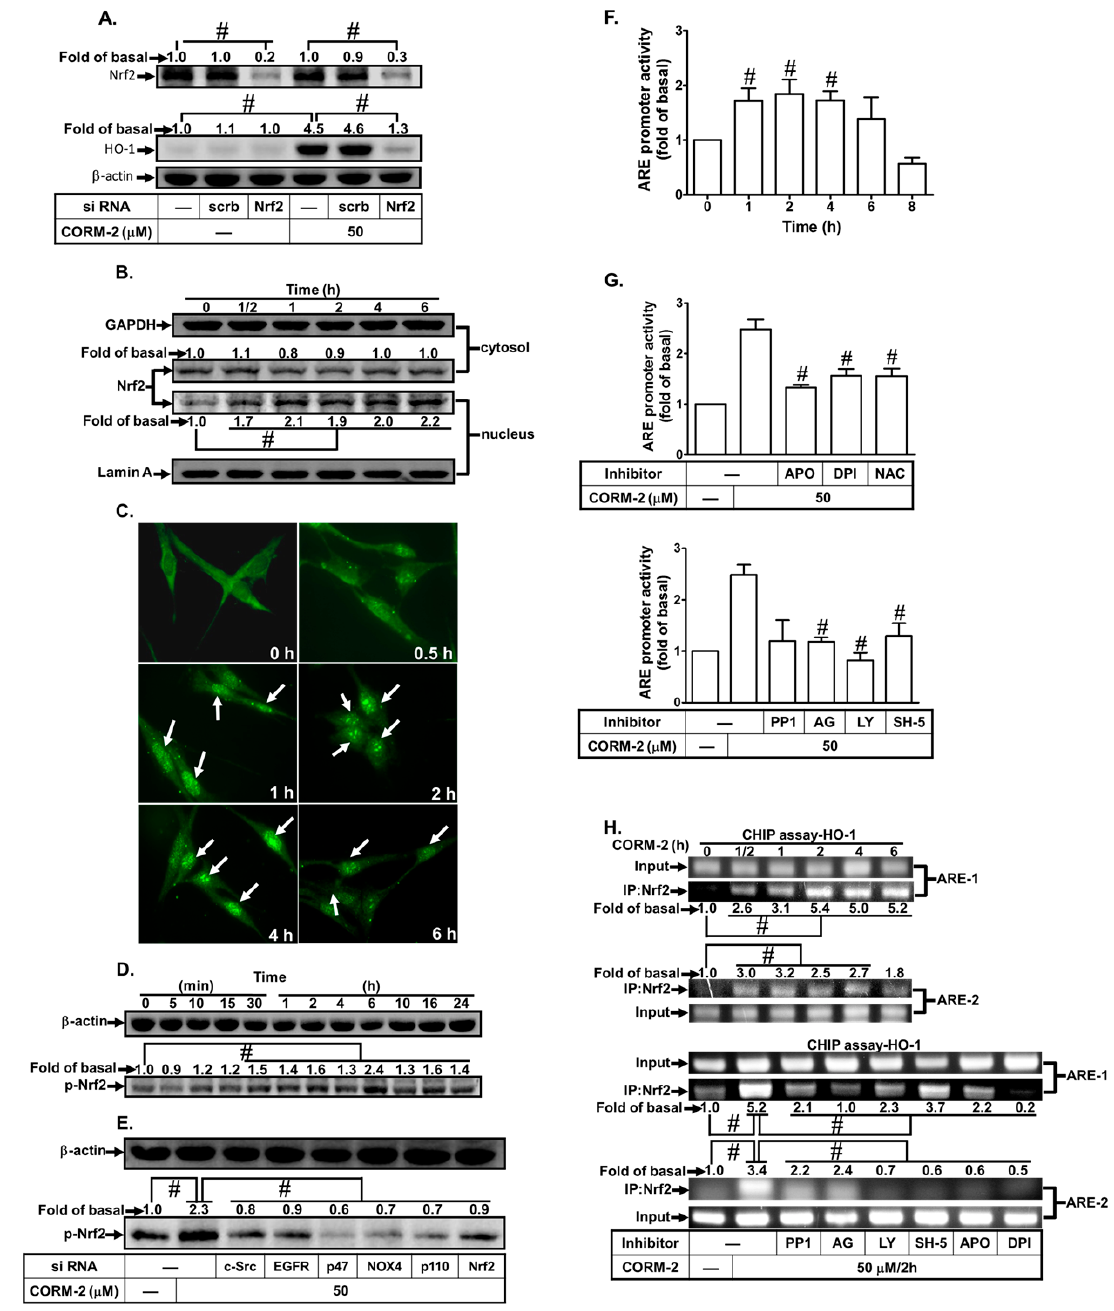
Figure 7. CORM-2 induces HO-1 expression via Nrf2. ( A ) HPAEpiCs were transfected with scrambled or Nrf2 siRNA and then incubated with CORM-2 for 16 h. The levels of Nrf2, HO-1, and β -actin